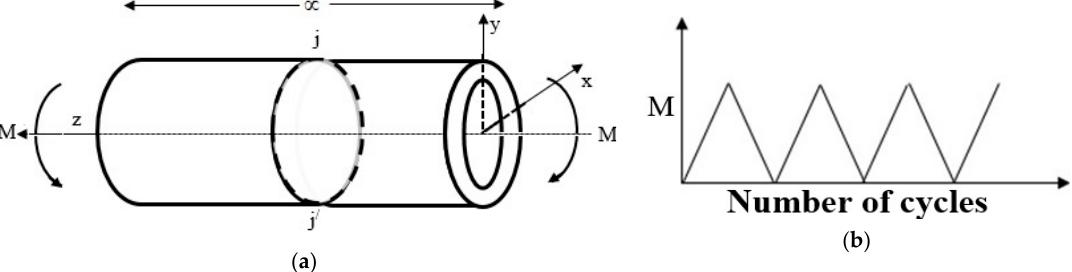
Figure 1. ( a ) Geometrical model of functionally graded material (FGM) cylindrical shell under constant internal pressure and cyclic bending moment. ( b ) Cyclic bending moment applied to the FGM cylindrical shell .